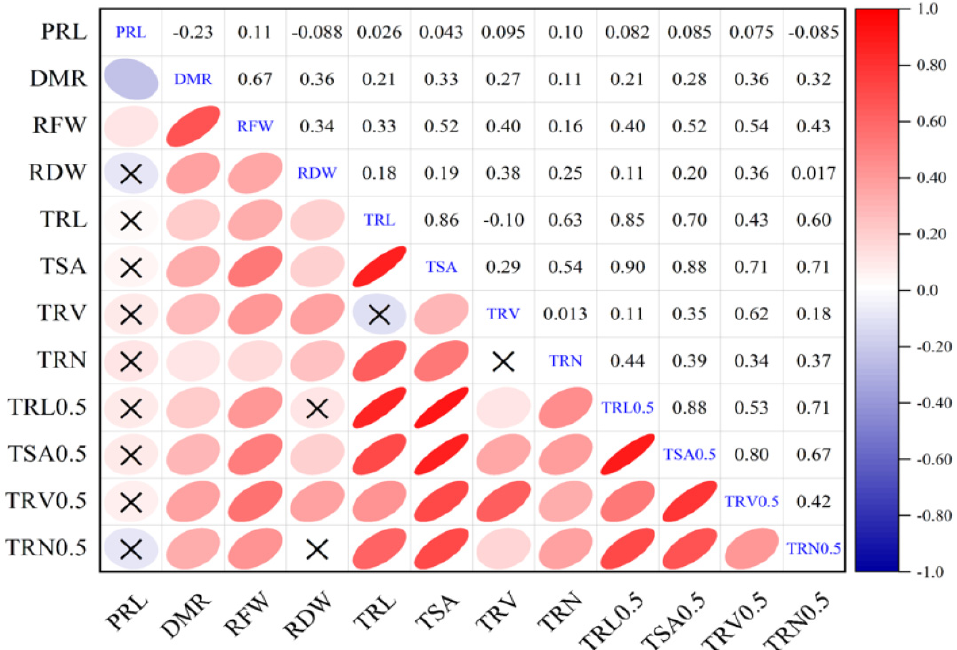
Figure 1. Correlation analyses between root-related traits. The plots on the diagonal line show the traits. Above the diagonal line are Pearson correlation coefficient values between traits. The plots below the diagonal line indicate the strength of the correlation coefficient values; ellipses with “X” inside them depict insignificant correlation. Significant differences at p < 0.05. Refer to Table 1 for the definition of terms.